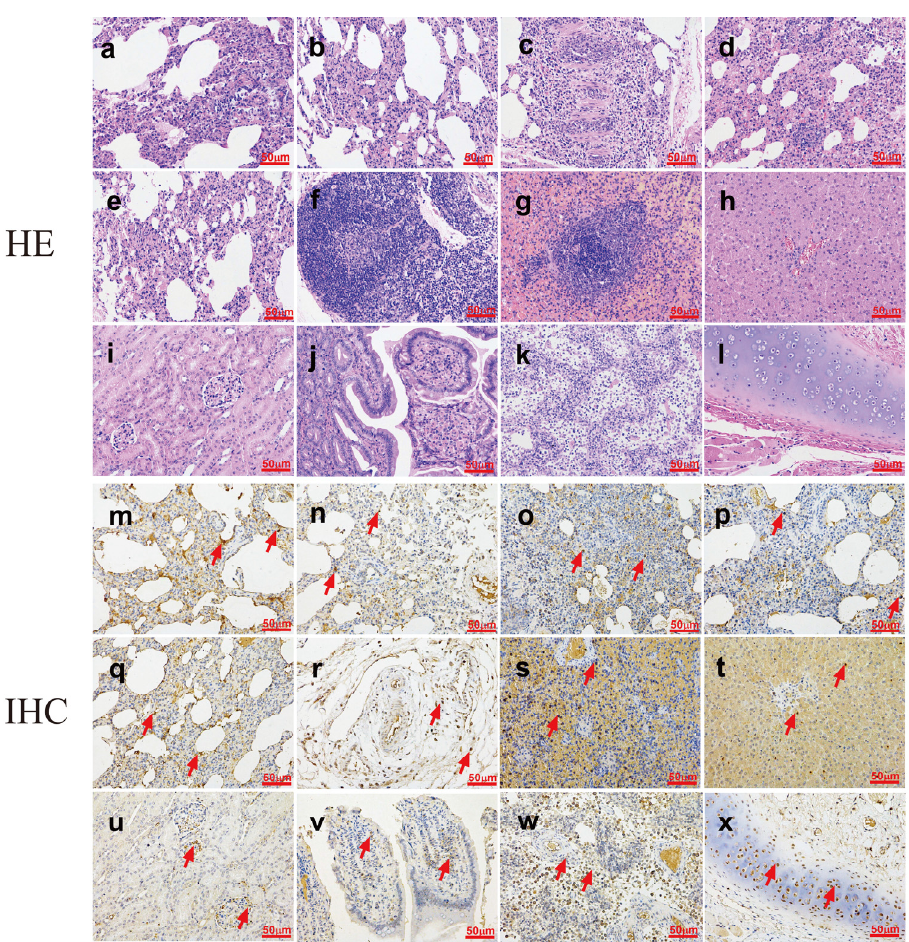
Figure 4. Histopathological analysis of dogs. Dogs were killed on 3 dpi with 10 7 EID 50 of the test virus. H&E staining images ( a – l ). ( a – e ) Lungs from H3N2 virus-infected dogs, with collapsed alveolar septum and alveolar cavity expansion and some lymphocyte infiltration of the stroma. ( f ) Hilar lymph nodes in dogs infected with H3N2 virus manifested as lymphoid tissue hyperplasia. ( g ) The liver of dogs infected with the H3N2 virus shows mild edema of hepatocytes. Spleen ( h ), kidney ( i ), and duodenum ( j ) are normal. ( k ) The mesenteric lymph node tissues of H3N2 virus-inoculated animals show mild histopathological changes. ( l ) Sloughing in the trachea. IHC for nucleoprotein (NP) detection in sections of intranasally infected dogs. Images from ( m ) to ( x ) after IHC: ( m–q ) a high viral antigen titer was detected in the lung tissues. Hilar lymph nodes ( r ), liver ( s ), spleen ( t ), kidney ( u ), duodenum ( v ), mesenteric lymph nodes ( w ), and trachea ( x ) showed only a mild presence of viral antigen. Red arrow, viral antigen positivity. Scale bars in ( a – x ), 50 µ